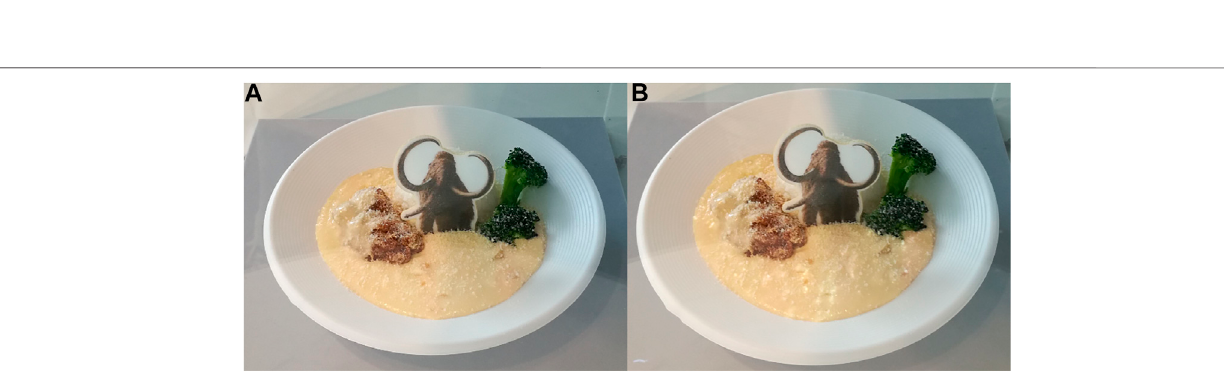
FIGURE 10 | Food showcase used in the study and where it was placed in the restaurant fl oor.